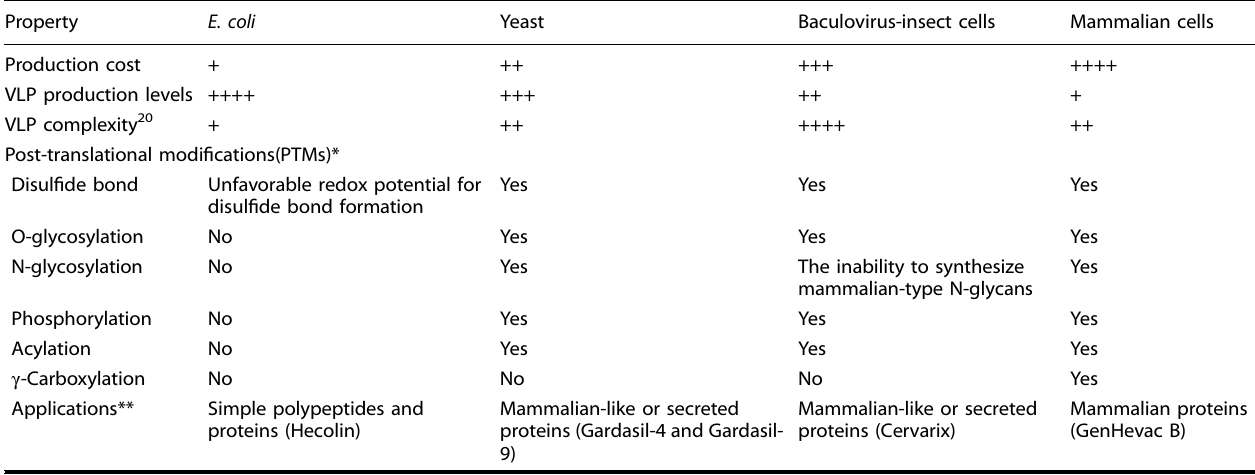
Table 2. A brief comparison among different systems with respect to their applications in producing recombinant VLPs Property